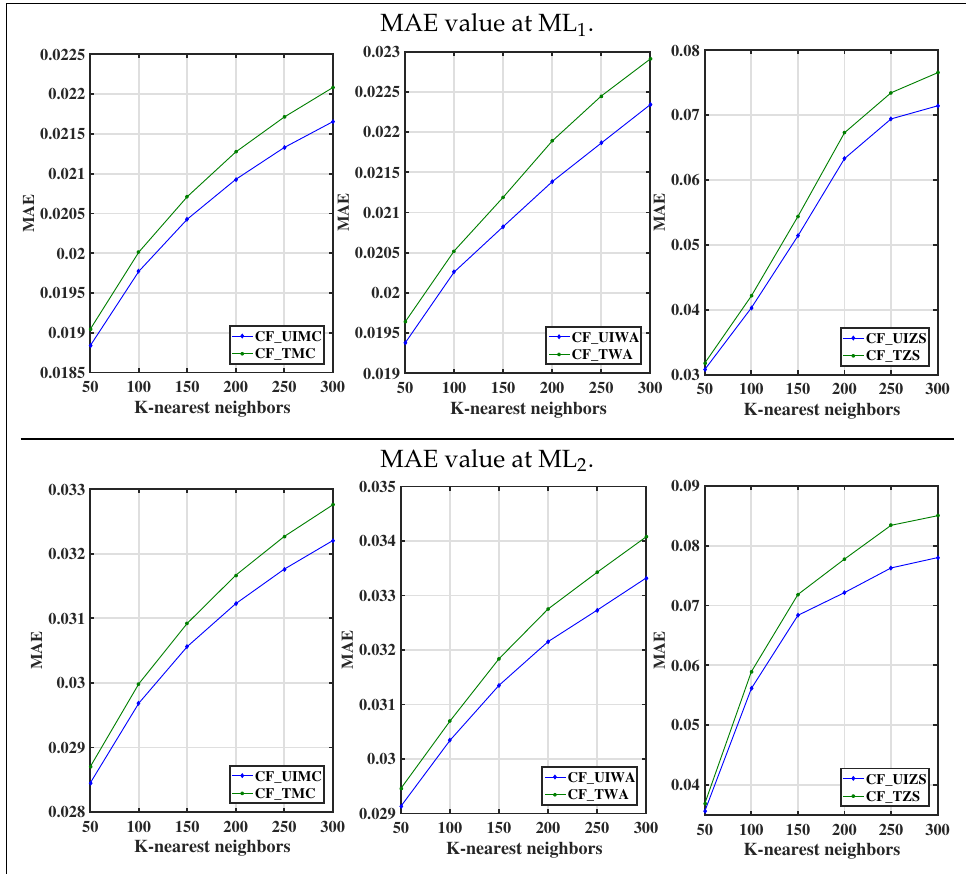
Figure 2. MAE Value at